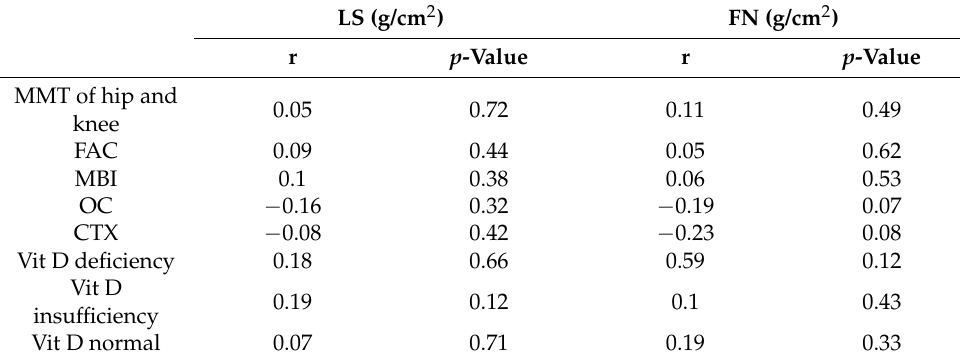
Table 3. Correlation between BMD and clinical parameters.